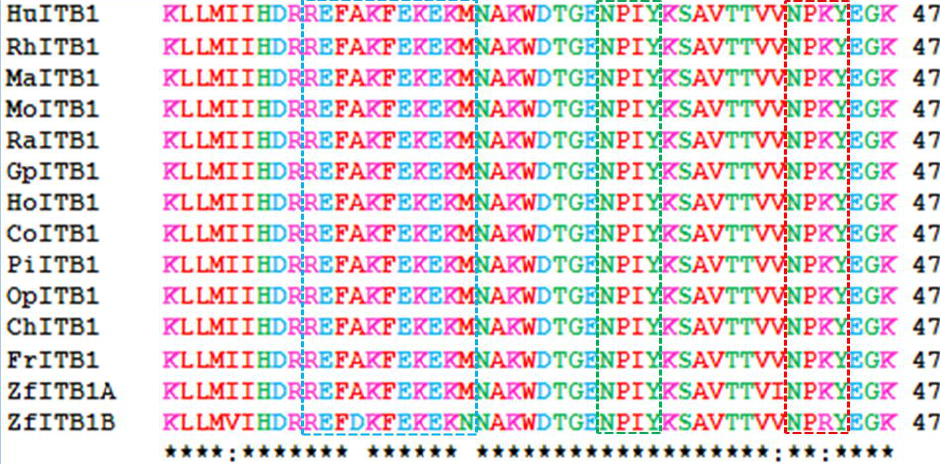
Figure 2. Amino acid alignments for vertebrate ITB1 cytosolic domain sequences. ITB1 sequences examined included Hu-human; Rh-rhesus; Ma-marmoset; Mo-mouse; Ra-rat; Gp-guinea pig; Ho-horse; Co-cow; Pi-pig; Op-opossum; Ch-chicken; Fr- Xenopus tropicalis ; Zf-zebrafish; see Table 1 for details; note that 2 ITB1-like genes were observed in zebrafish (designated as ITB1A and ITB1B); * shows identical residues for ITB subunits; : similar alternate residues; . dissimilar alternate residues; α - helix for vertebrate ITB sequences is in shaded yellow; β-sheet is in shaded grey; colors for amino acids are shown as: basic (R and K); acidic (D and E); neutral hydrophilic (G, Y, Q, S, T, N, Y, C, H); and hydrophobic (M, A, F, I, L, W, P, V); the Cyto-1, Cyto-2 (NPXY) and Cyto-3 (NXXY) domains are shown in dotted lines (see text for